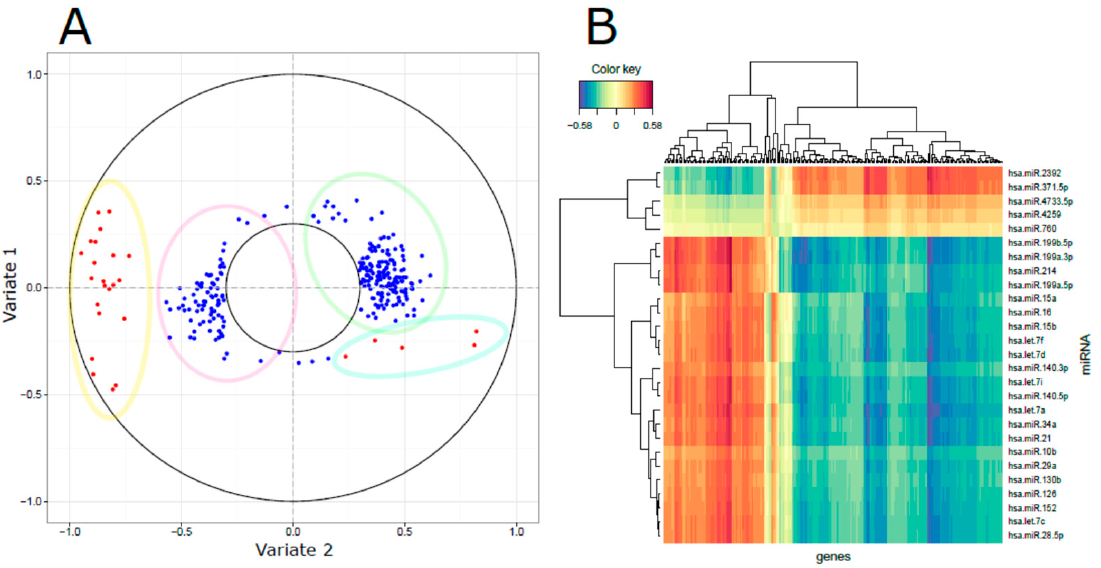
Figure 3. Identification of integrated miRNA and mRNA networks: ( A ) The correlation circle plot displays the features (miRNAs = red; genes = blue) and the position derived by the combination of the first and second variates in our rCCA. The features in the area outside the inner ring (radius < 0.3) were retained as significant and shown in the plot. The ellipses depicted four miRNA/gene clusters and the list can be found in Supplementary Materials Table S2; ( B ) The CIM plot displays the correlation structure between the features. Each colored block represents an association between miRNAs and genes spanning a range of colors from blue (negative correlation), to yellow (weak correlation), to red (positive correlation). The dendrograms on the top and left side indicate how genes and miRNAs, respectively, are connected.